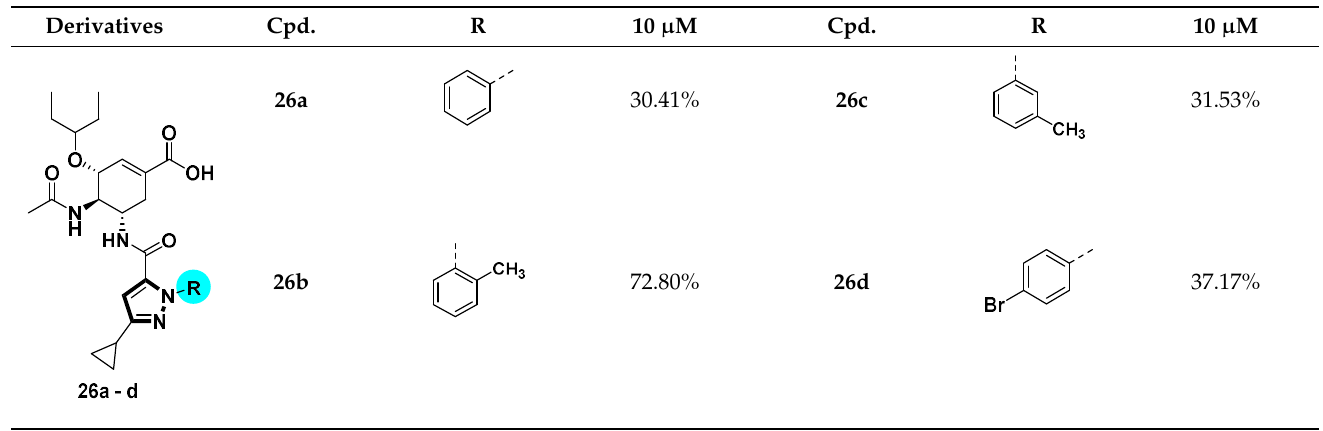
Table 2. Inhibitory activity of 6i , 12c , 24b , and 26b against clinically isolated A/H3N2 NA (μM) a . No.